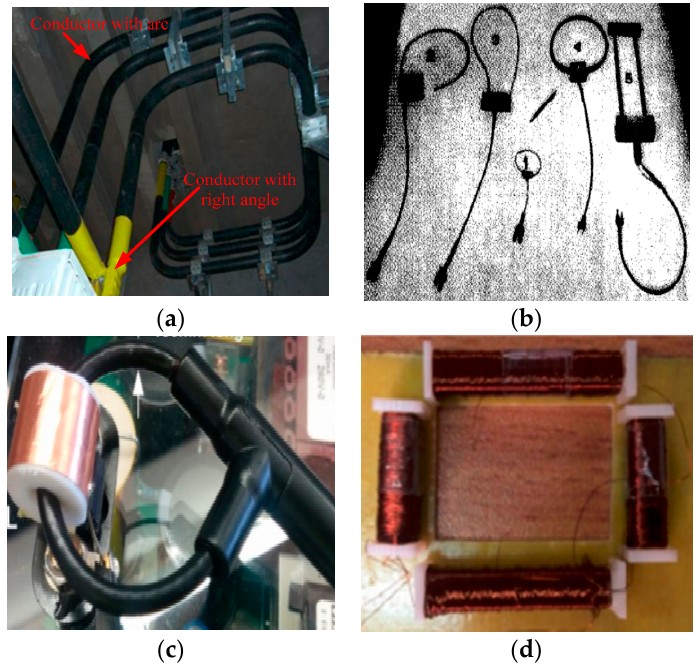
Figure 1. Conductors and Rogowski coils. ( a ) Conductors with some shapes; ( b ) five Rogowski coils of different structures; ( c ) non-circular Rogowski coil; ( d ) rectangular Rogowski coil.